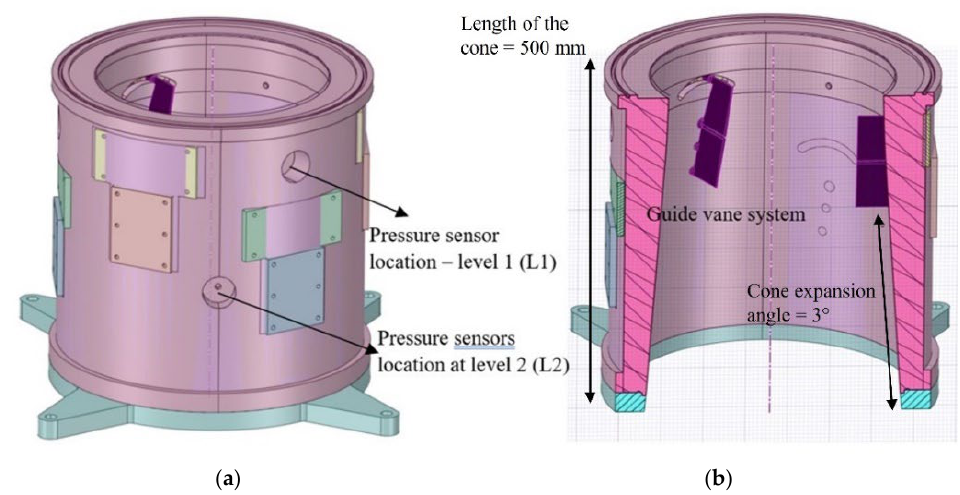
Figure 2. The draft tube cone and pressure taps location in the Francis model turbine: ( a ) outer section of the cone showing the pressure taps locations; ( b ) inner section of the draft tube cone showing the GVs.